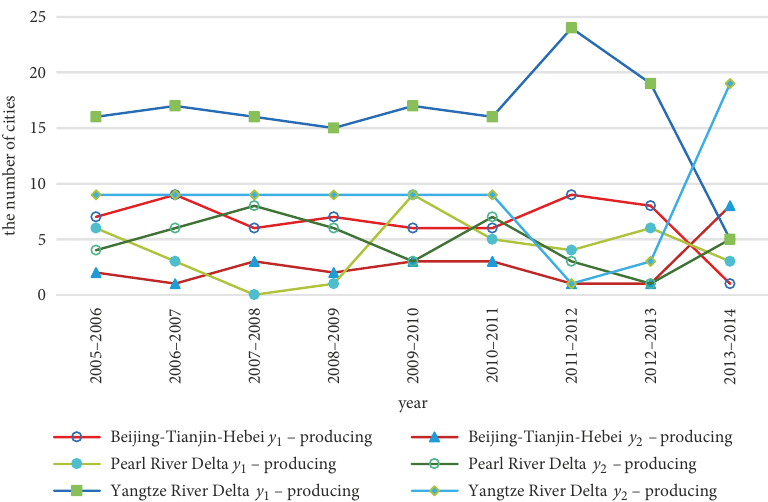
Figure 11. Output biased technological changes of GDP ( y 1 ) and CO 2 ( y 2 ) in each of the urban